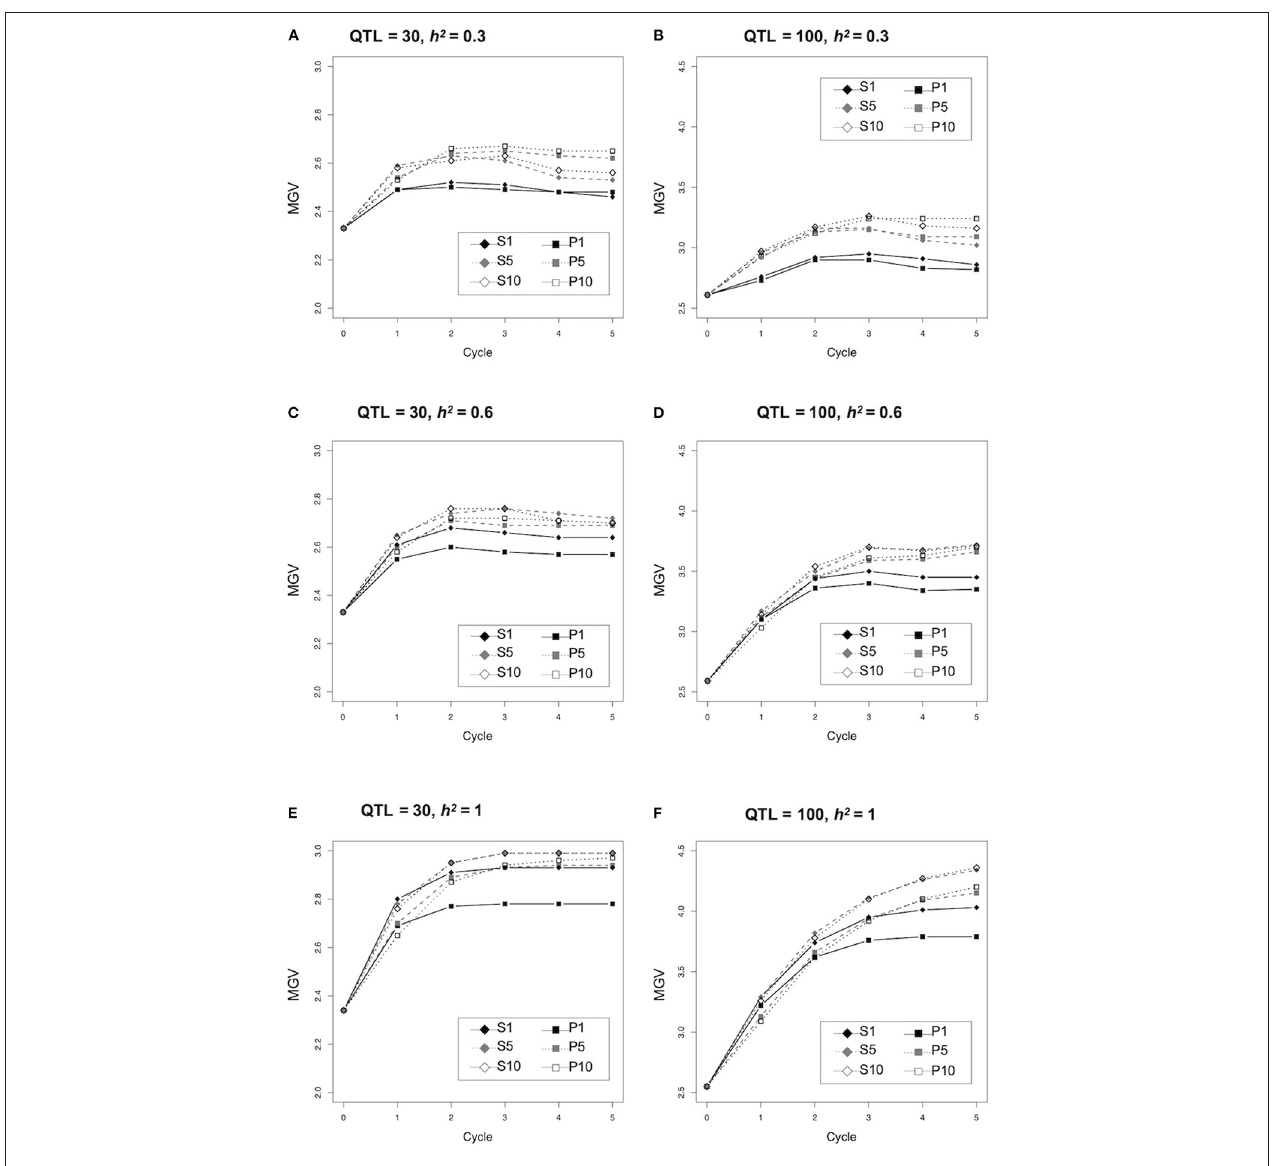
FIGURE 2 | Comparison of genetic improvement during selection cycle of the different selection strategies. Y-axis indicates the maximum genetic values (MGVs).